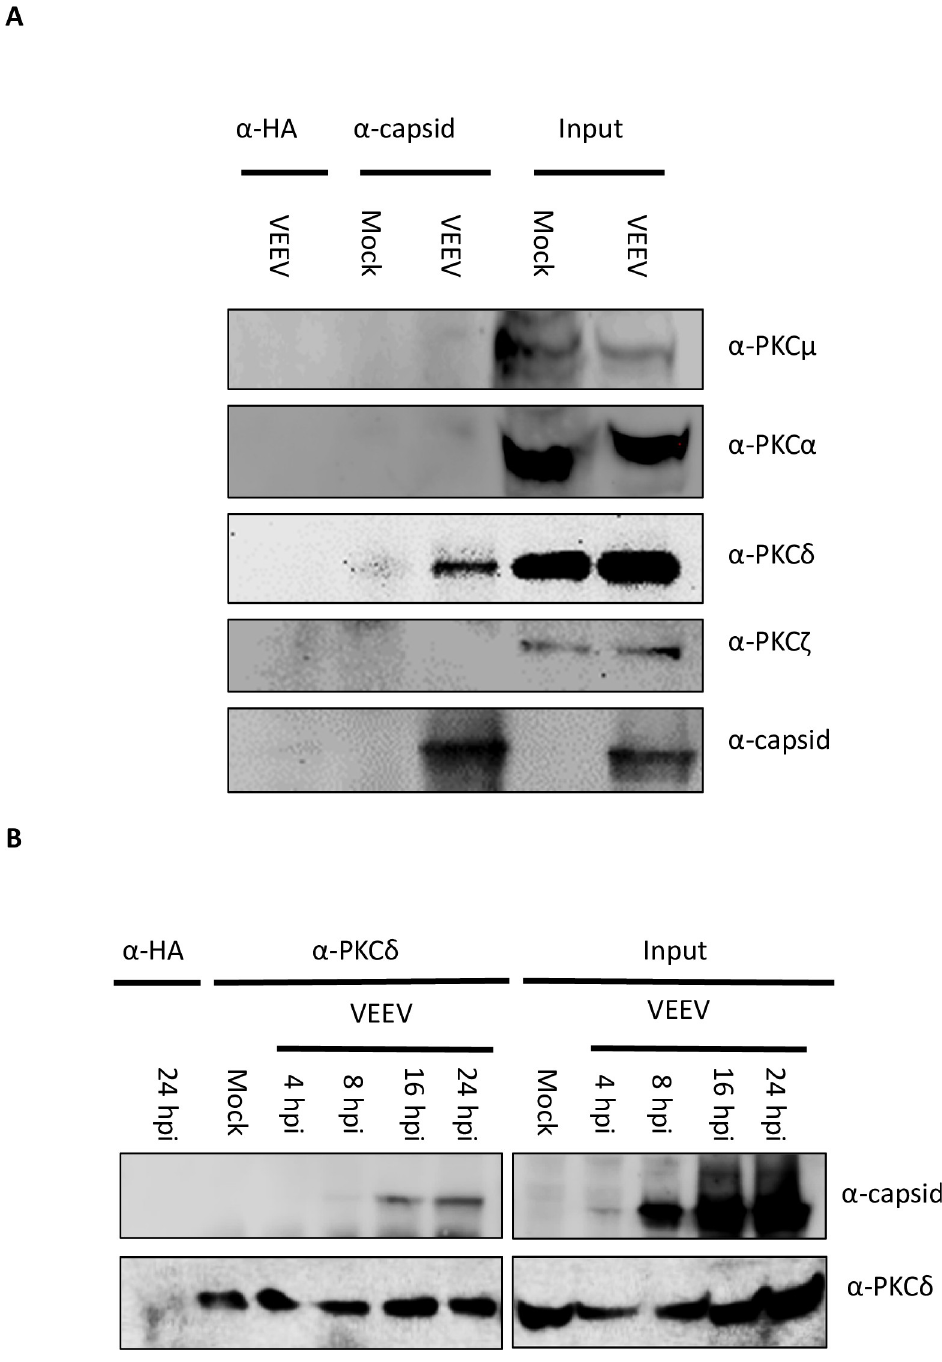
Fig 1. VEEV capsid co-immunoprecipitates with PKC δ , but not other PKC family members. A) Vero cells were mock-infected or infected with VEEV TC-83 (MOI of 1.0) for 24 hours. Cells were lysed and 1 μ g of either α -HA or α - capsid antibody was added to 1 mg of protein lysate. Protein complexes were bound to Protein G Dynabeads, and samples were run on SDS-PAGE and western blot analysis was performed for VEEV capsid and each PKC isoform shown. Images are representative of 3 biological replicates. B) Vero cells were mock-infected or infected with VEEV TC-83 (MOI of 1.0) and collected at the indicated time points. Cells were lysed and 1 μ g of either α -HA or α -PKC δ antibody was added to 1 mg of protein lysate. Protein complexes were bound to Protein G Dynabeads, samples were run on SDS-PAGE and western blot analysis was performed for capsid and PKC δ . Images are representative of 3 biological